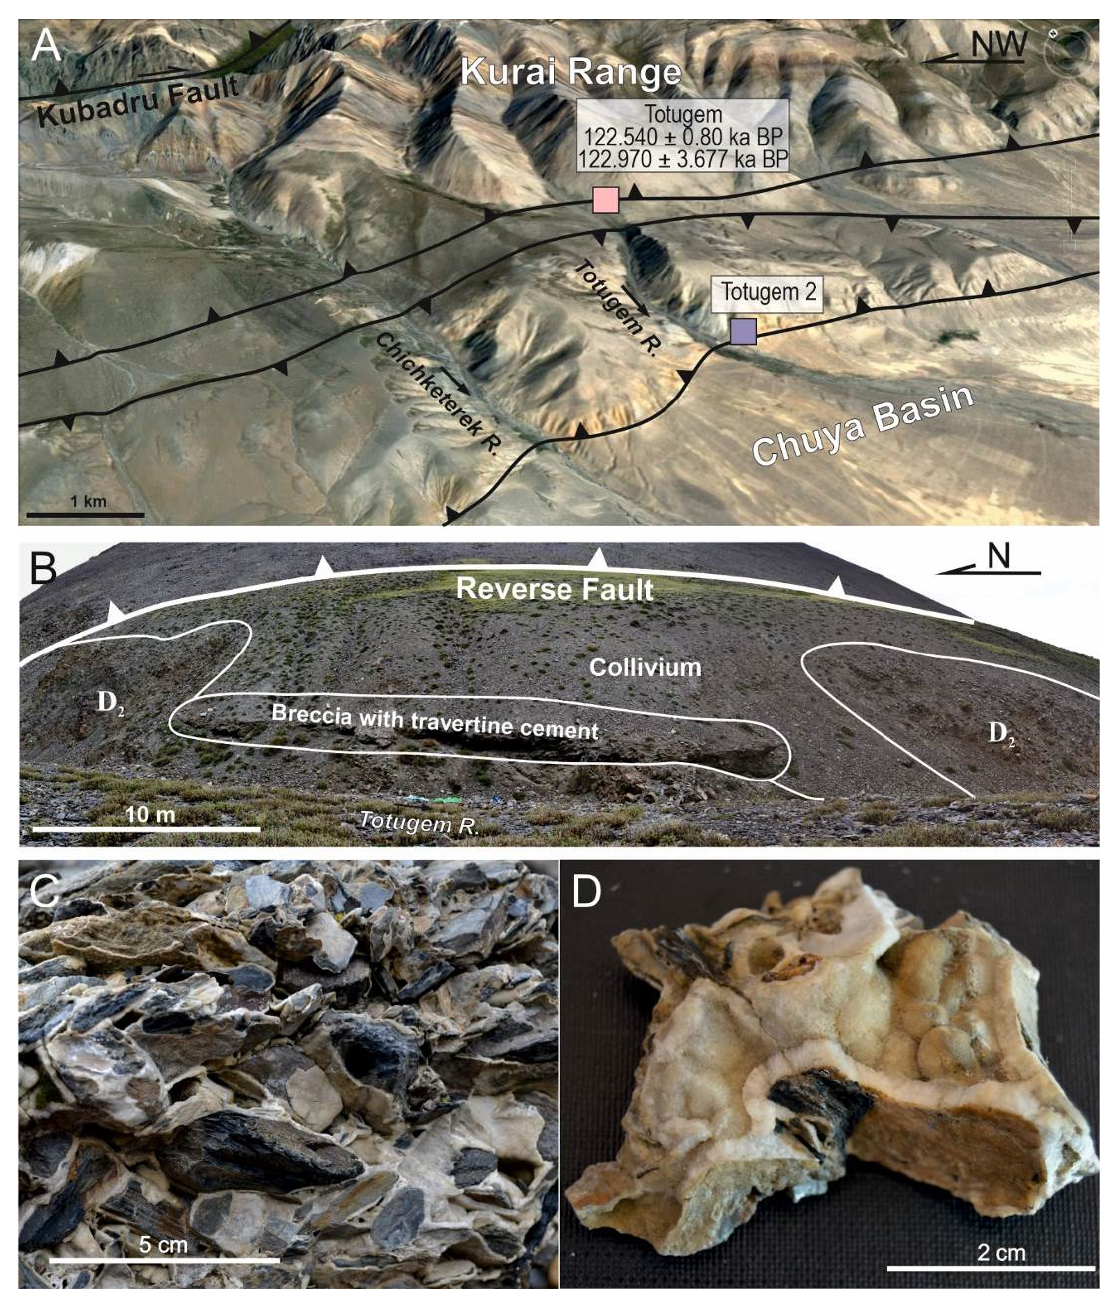
Figure 7. Location and morphology of the Totugem travertines. ( A ) Active faults, location, and U-Th dates of the Totugem travertines (50.11039° N, 88.60268° E). ( B ) Outcrop of the breccia with travertine cement on the left bank of the Totugem River. ( C ) Breccia with travertine cement. ( D ) Close-up: travertine cement of